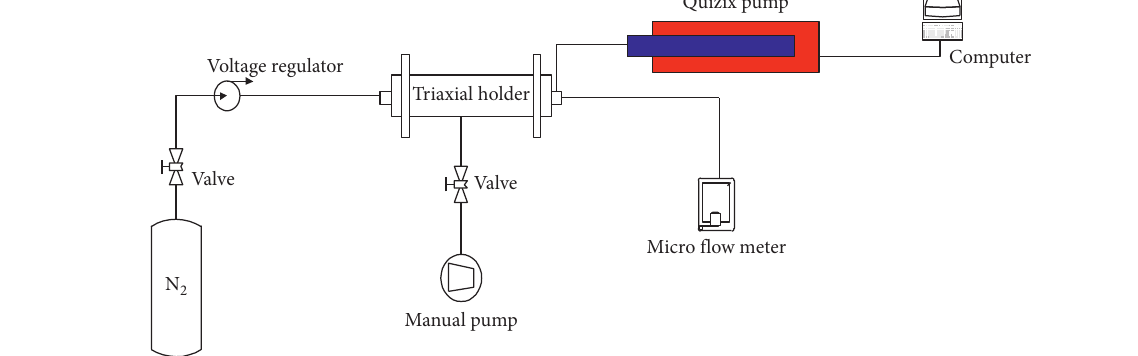
Figure 1: Core casting experiment diagram.